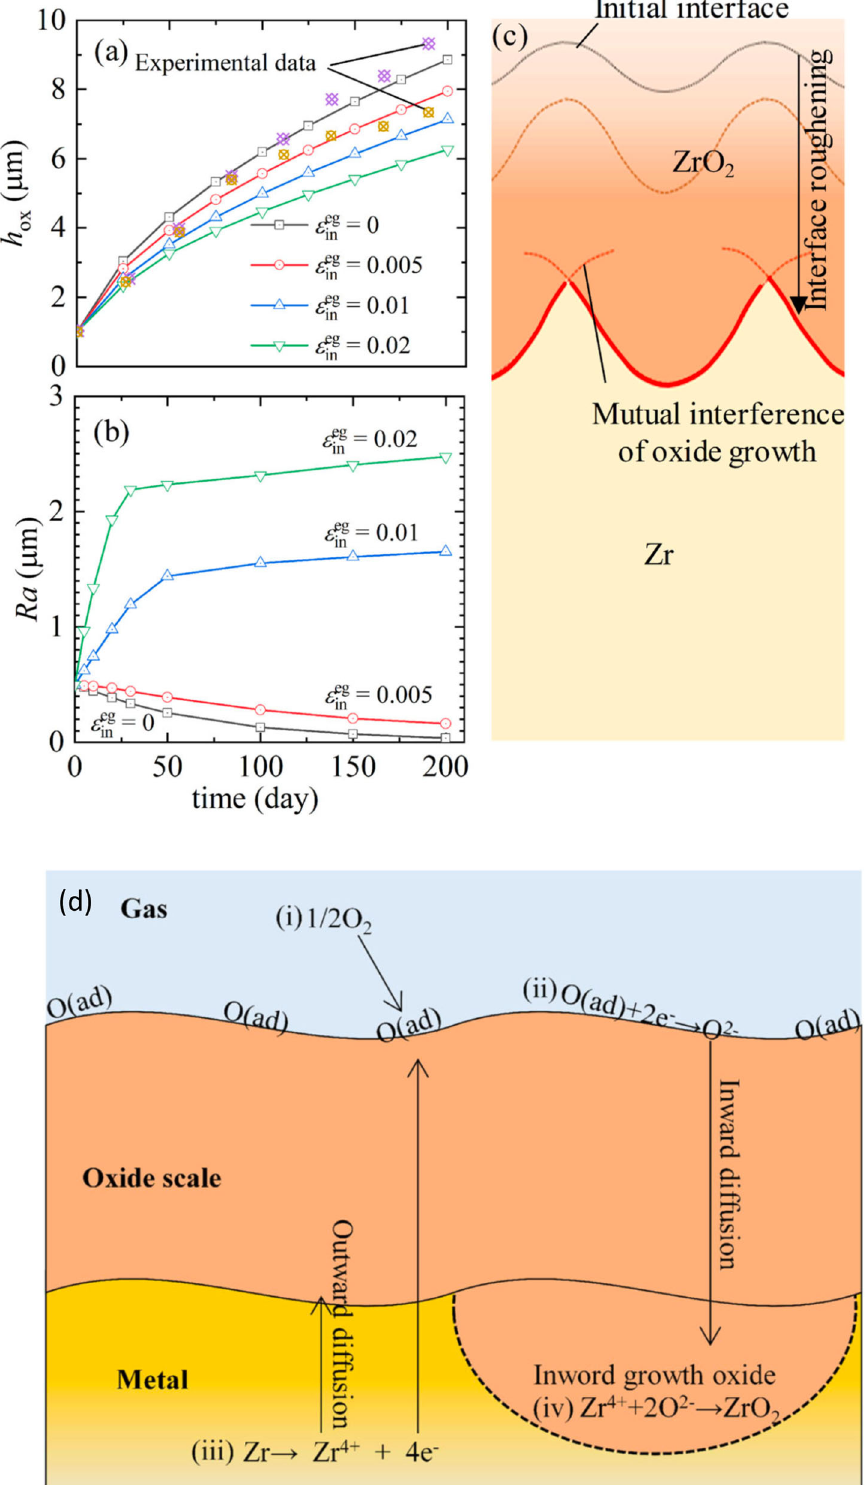
Fig. 10 High-temperature metal oxidation. Variations of oxide scale roughening for different eigenstrains (estimated from different PB ratio). a Oxide scale ( h ox ) and b interface roughness (Ra) versus time. c Schematic of interference between neighboring oxide bumps as they grow. d Schematic of metal oxide growth in a gaseous environment. a – d are reproduced with permission from ref. 162 , published by nature springer in